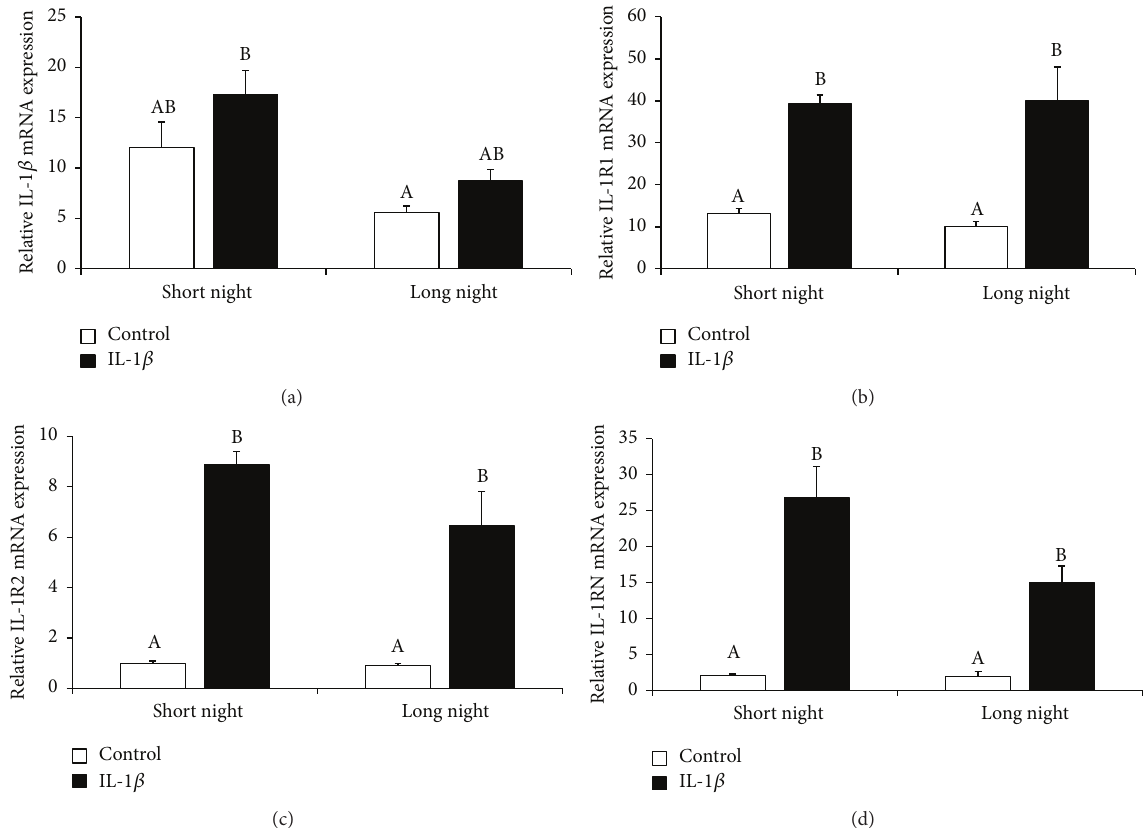
Figure 6: The effects of icv. injection of interleukin- (IL-) 1 𝛽 (50 𝜇 g/animal) or Ringer’s solution (50 𝜇 L) on the relative gene expression (mean ± SEM; 𝑛 = 6 animals per group) of IL-1 𝛽 (a), interleukin 1 type 1 receptor (IL-1R1, (b)), interleukin 1 type 2 receptor (IL-1R2, (c)), and interleukin 1 receptor antagonist (IL-1RN, (d)) in ewes during the short night (SN, May/June) and long night (LN, November/December) photoperiods. All data presented in the figure were normalised to the average relative level of IL-1R2 gene expression measured in the control ewes from the SN photoperiod, which was set to 1.0. Different capital letters indicate significant ( 𝑃 < 0.05 ) differences according to a two-way ANOVA followed by Tukey’s post hoc